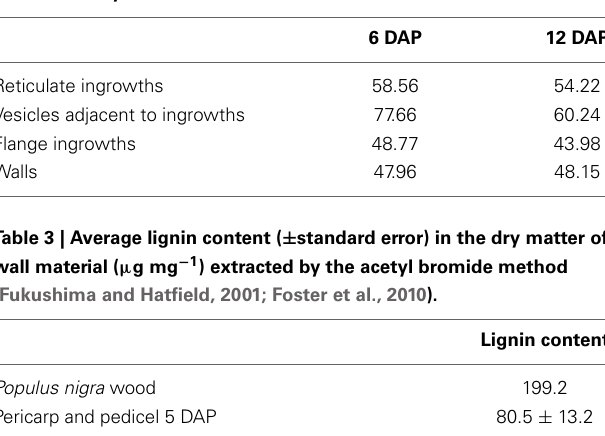
Table 2 | The average percentage reduction of Mn deposition after H 2 O 2 treatment prior to KMnO 4 staining in MBETC at 6 and 12 DAP, determined by TEM–EDS.